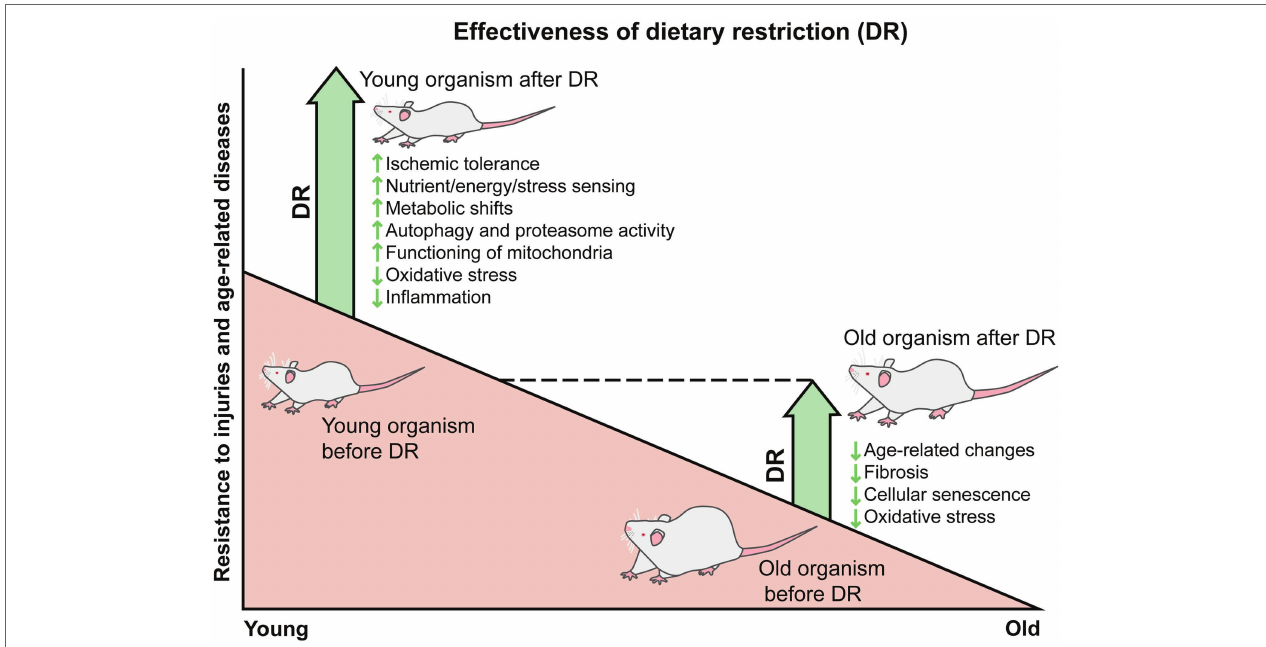
FIGURE 1 | Gradual reduction of the DR protective effects from injuries and age-related changes. In young animals, DR is accompanied by many positive changes, such as enhanced response of nutritional and stress-sensing pathways, metabolic shifts toward lipid utilization and ketone bodies production, autophagy and proteasome activation, improvement in mitochondria functioning, reduced oxidative stress and inflammation, and subsequent resistance to injuries, including ischemic ones. In old animals, DR is associated with a smaller range of positive changes, such as delaying age-related changes and the formation of fibrosis, reducing the number of senescent cells, oxidative stress, and chronic inflammation. The adult-onset DR does not improve all age-related impairments in all organism’s systems, so old animals kept on DR do not fully reach the state of young healthy